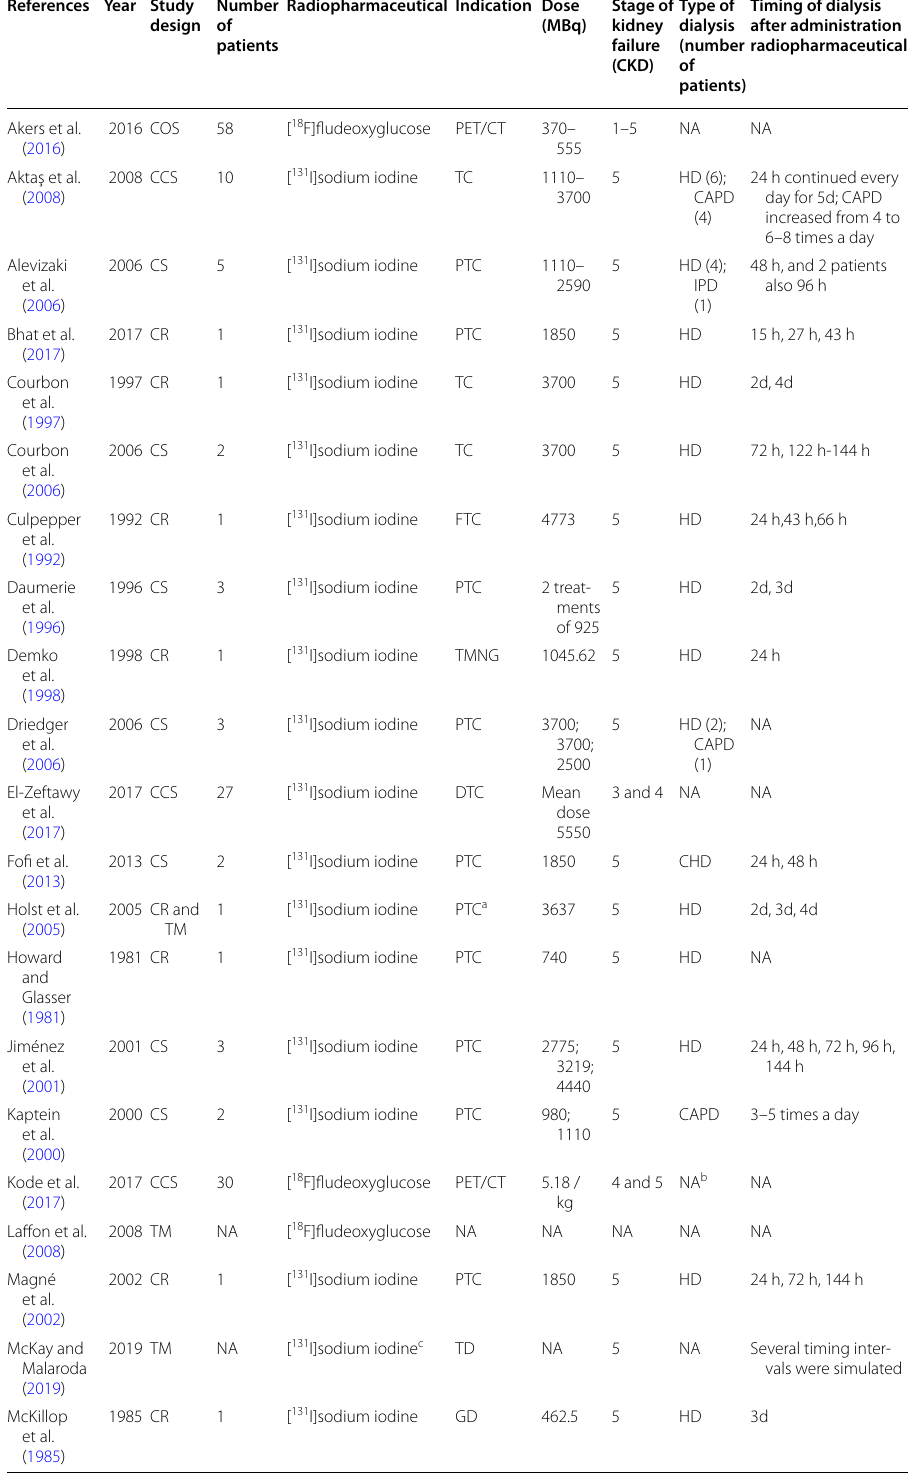
Table 3 Overview of included studies with their characteristics References Year Study